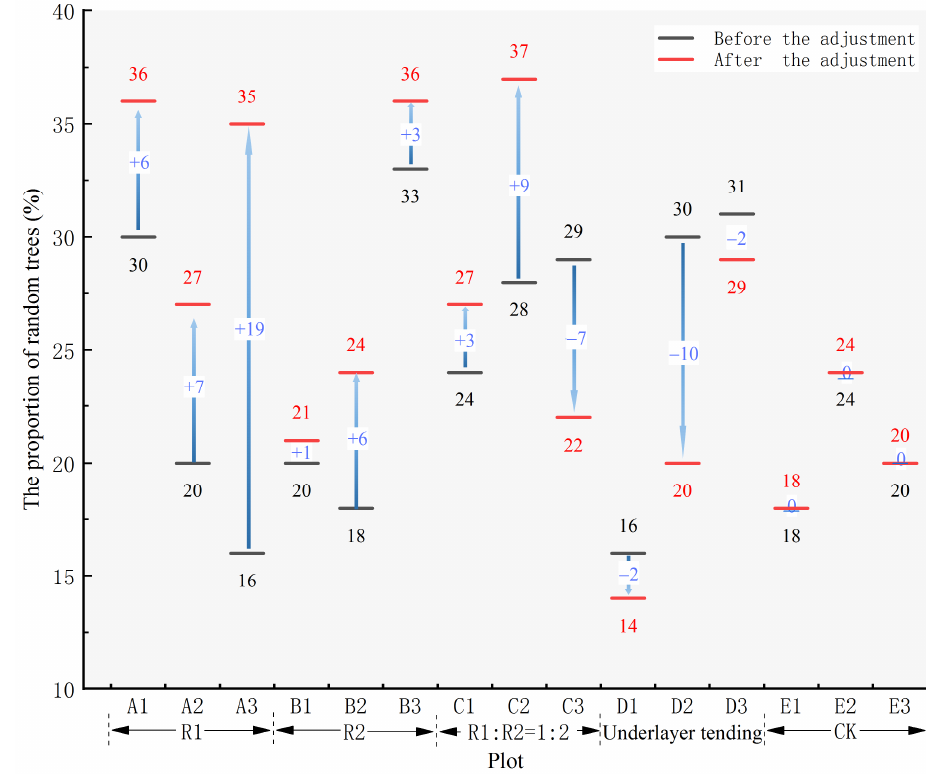
Figure 5. Changes in random tree proportion in different management modes.